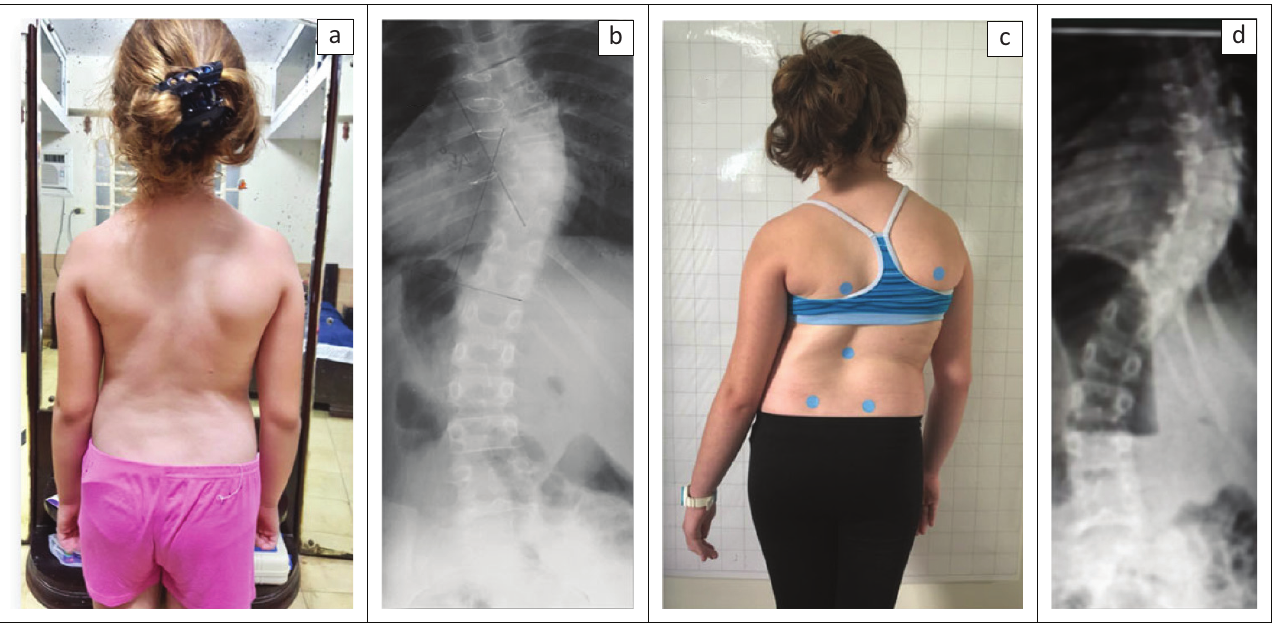
FIGURE 1: Significant progression of the curve within 18 months from 45° (a and b) to approximately 65° Cobb (c and d). Whilst the trunk of the patient was compensated at the age of eight (a), at the start of treatment at 9.9 years, the patient showed signs of a collapsing spine with a drastic decompensation of the trunk to the right side.